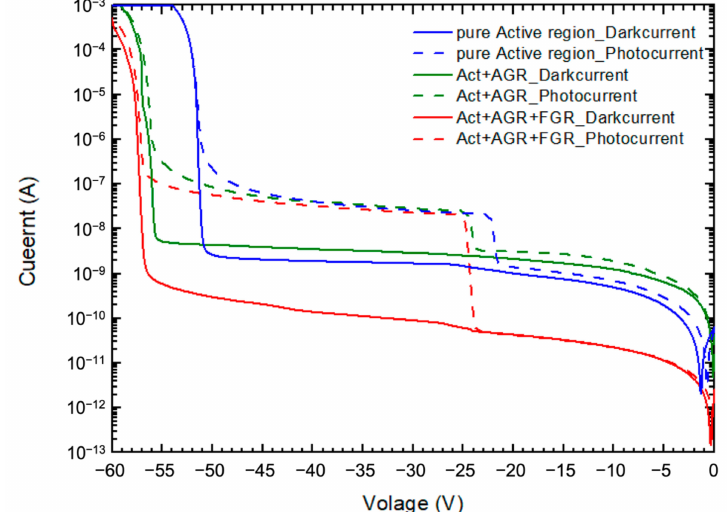
Figure 4. Dark current (solid) and photo current (dash) of APD devices with three different designs: without guard ring (blue, Device A), with AGR only (green, Device B), and with AGR and FGR (red, Device C).